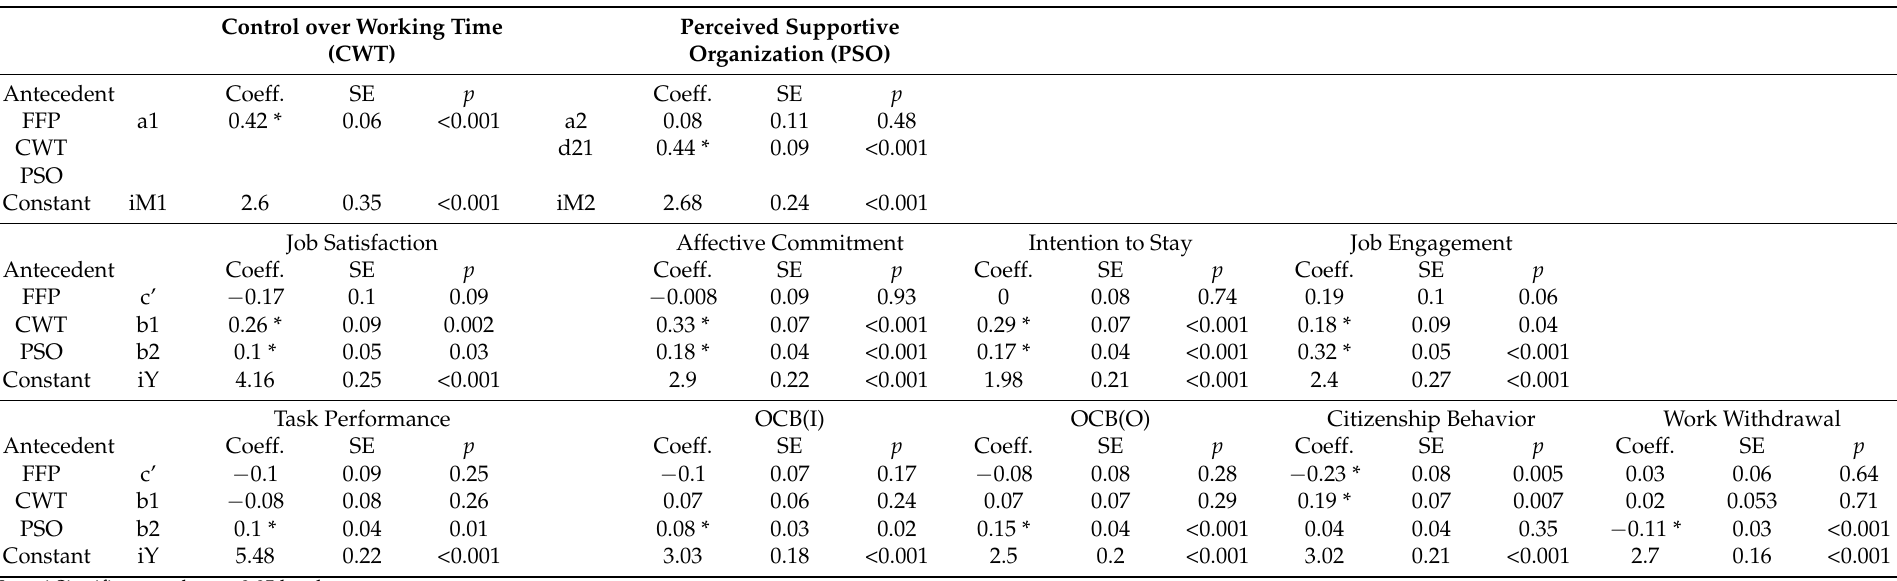
Table 3. Association of availability and utilization of family-friendly policies with work attitude and behavior through increased control of working hours. Control over Working Time Perceived Supportive (CWT) Organization